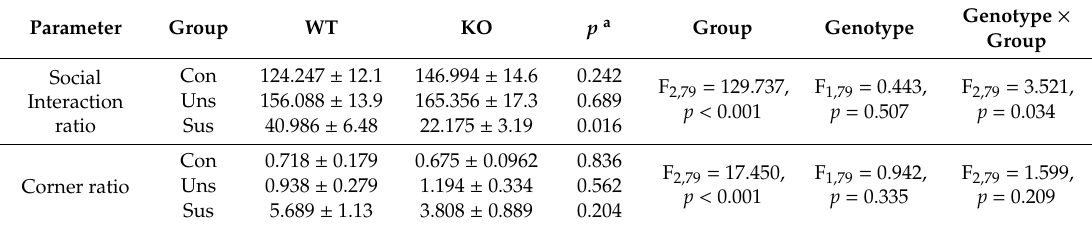
Table 1. Results of two-way analysis of variance (ANOVA) for social